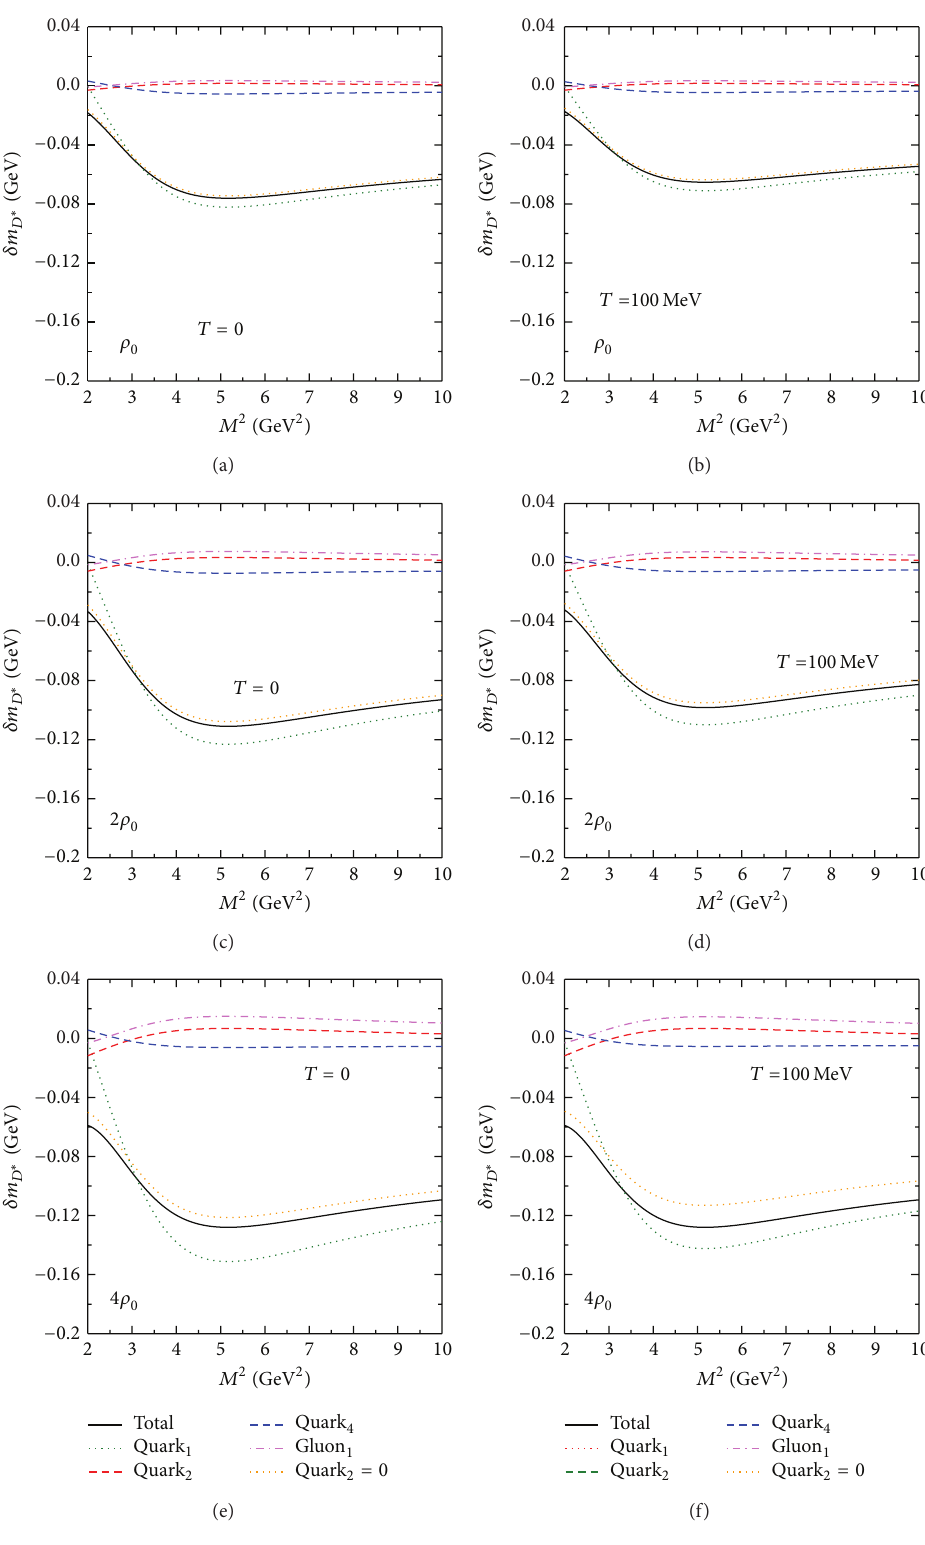
Figure 7: (Color online) Figure shows the contribution of individual condensates to the mass shift of vector mesons 𝐷 ∗ as a function of the squared Borel mass parameter, 𝑀 2 . The subplots (a), (c), and (e) show the results at temperature 𝑇 = 0, whereas the subplots (b), (d), and (f) are plotted for temperature 𝑇 = 100MeV. We have shown the results at baryon densities 𝜌 0 , 2𝜌 0 , and 4𝜌 0